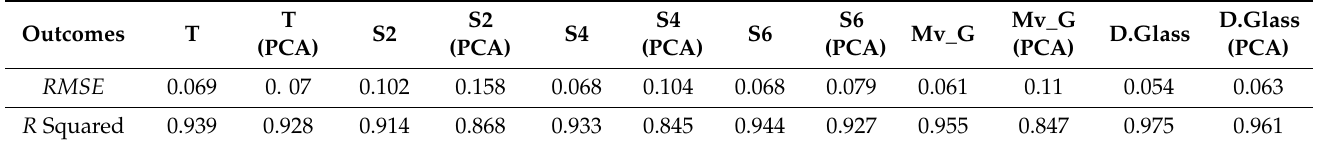
Table 5. RMSE and R squared of the ANN forecasting